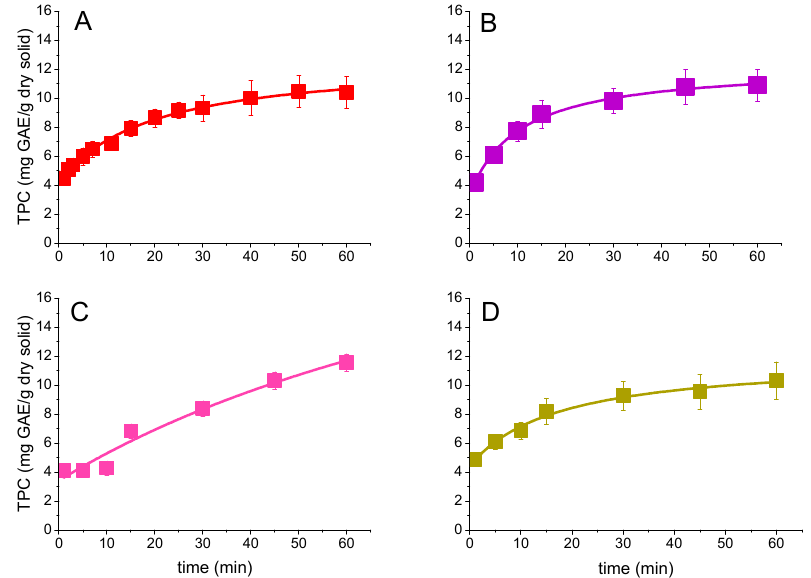
Figure 2. Kinetic analysis of the extraction processes of AP employing ( A ) acetone at 25 ◦ C, ( B ) acetone 80% at 25 ◦ C, ( C ) water at 25 ◦ C, and ( D ) ethanol 96% ( v / v ) at 70 ◦ C obtained by the Folin–Ciocalteu method. Fitting lines correspond to the second-order kinetic model shown in Equation (1).